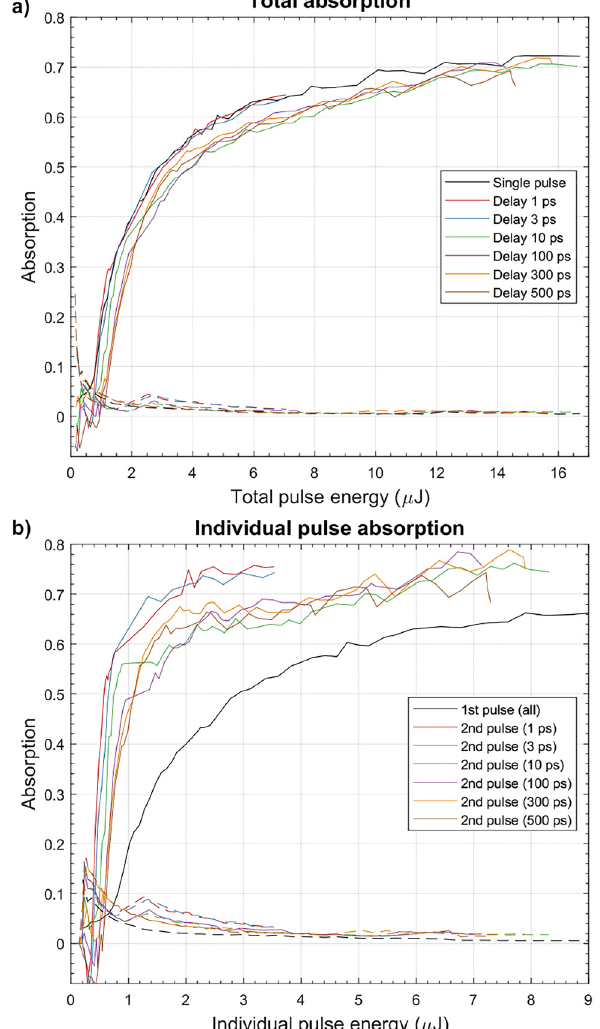
Figure 5: Absorption measurements of single and double pulses. (a) Total absorption of double pulses. (b) Absorption of the first and the second pulse. In (a) and (b), the dashed lines show the value of the standard deviation over 100 shots.